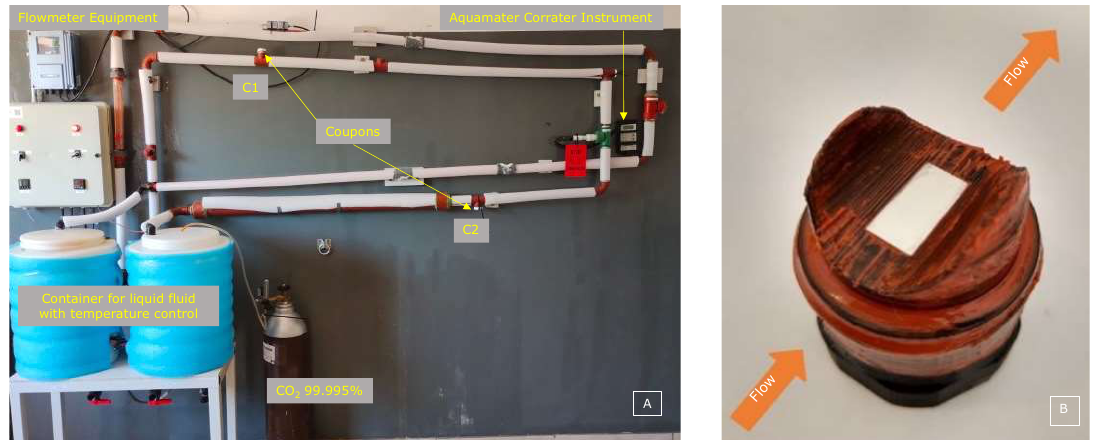
Figure 1. ( A ) Corrosion loop and its components; ( B ) coupon.